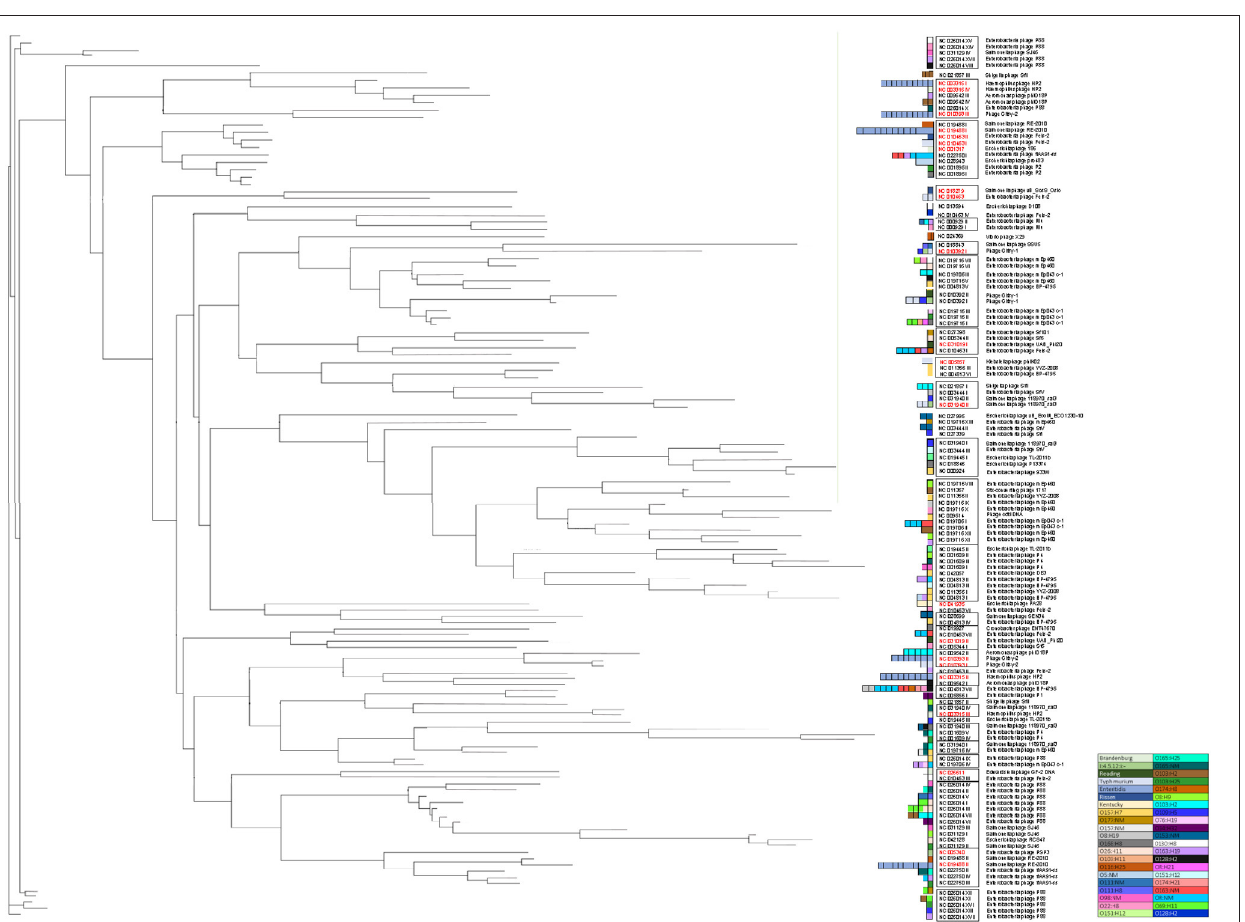
FIGURE 1 | Maximum-likelihood tree of 130 prophages identified in this study. For clarity, bootstrap values (all > 70%) are not shown. Scale bar represents the average number of nucleotide substitutions per site. Red font indicates prophages identified in our Salmonella strains. Colored boxes next to taxa names indicate serotype abundance and in which the prophages were